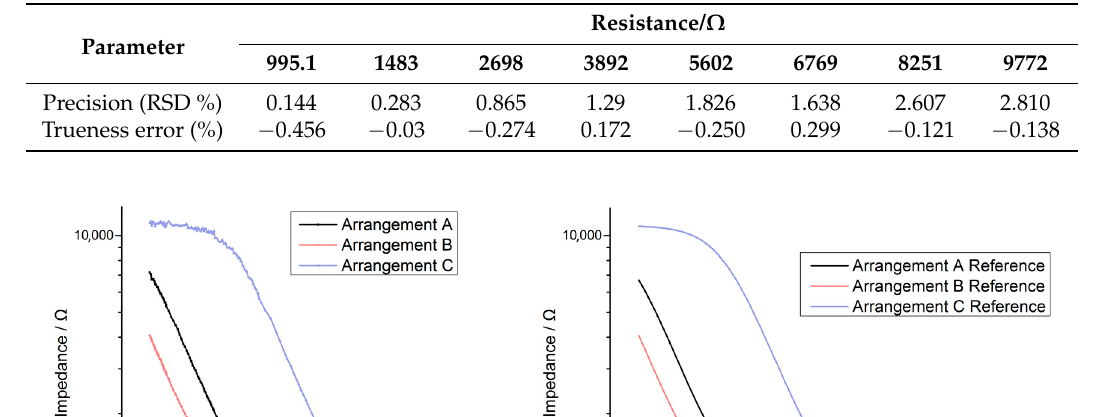
Table 4. Precision in relative standard deviations (RSD) and trueness error (averaged accuracy error) of the impedance sensor over an entire frequency sweep to determine the resistance of a series of test resistances. A two-point calibration method was used and the resistances were measured using a 4-point LCR meter (Escort ELC-3131D).